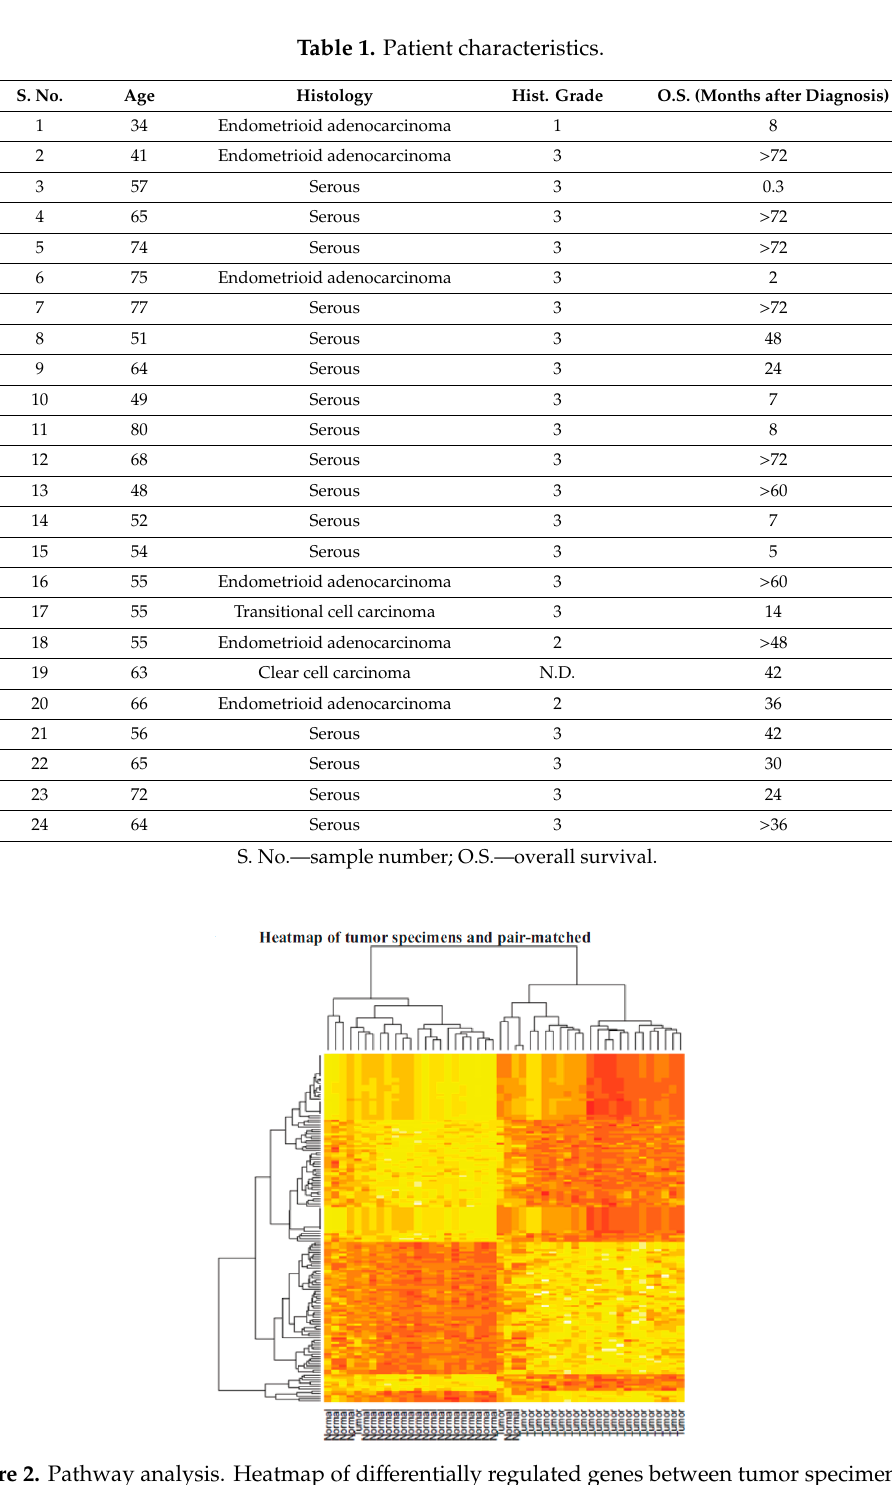
Figure 2. Pathway analysis. Heatmap of differentially regulated genes between tumor specimens and their respective pair-matched control specimens. The top 100 statistically significant genes were loaded into the Ingenuity Pathway Analysis (IPA) software for the identification of pathways and regulators that were enriched in this dataset (Table 2). The most enriched pathways identified by IPA are the integrin-linked pathway, tryptophan degradation X, putrescine degradation, insulin-like growth factor-1 signaling, and 14-3-3 sigma signaling. A significant enrichment of the ILK pathway was identified in 22 of the 24 cancer specimens, identifying this pathway as a potential player in the transformation of normal ovarian cells to cancerous cells (Table 2). The genes that represent the ILK pathway in the microarray included FOS, DSP, myosin 11 (MYH11), CDH1, mucin 1 (MUC1), and keratin (KRT18). While FOS and MYH11 were lower in the tumor specimens compared to their normal controls, the other genes were more prevalent in the tumor specimens. Interestingly, although c-FOS is a proto-oncogene,